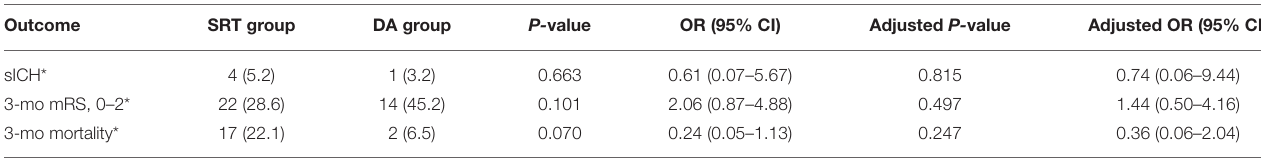
TABLE 2 | Multivariate regression analysis of effects of DA on sICH, functional outcomes and